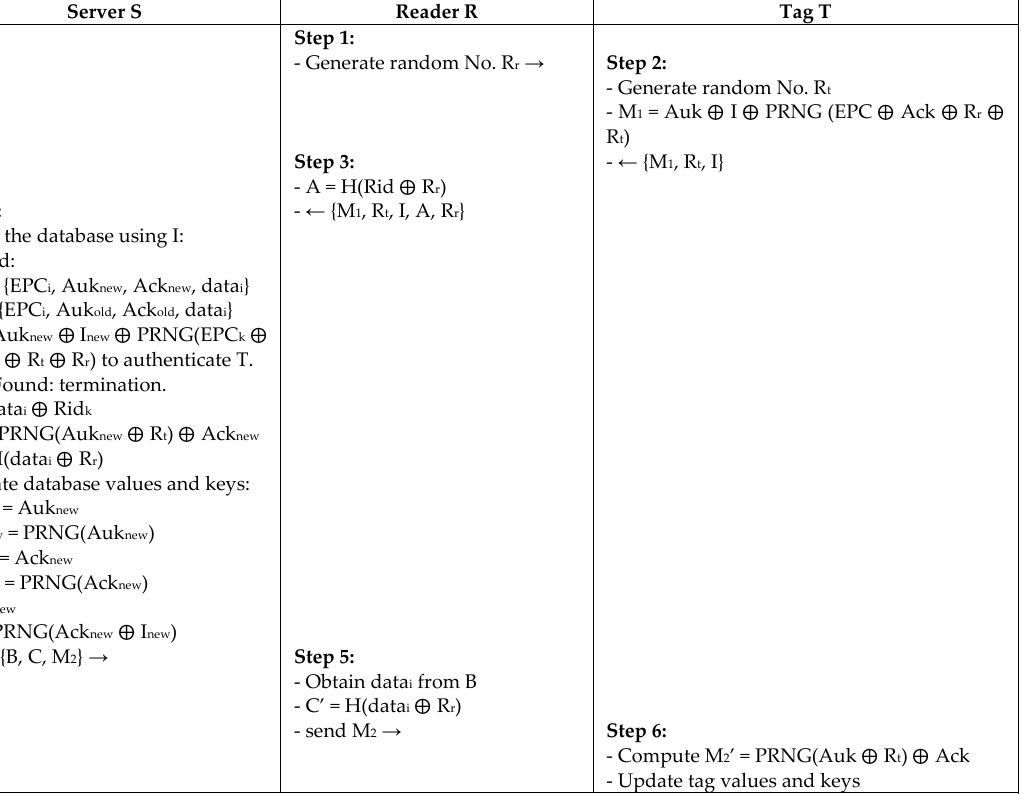
Figure 18. Hash-Based Mutual Authentication (HBA+) Protocol by Chang.